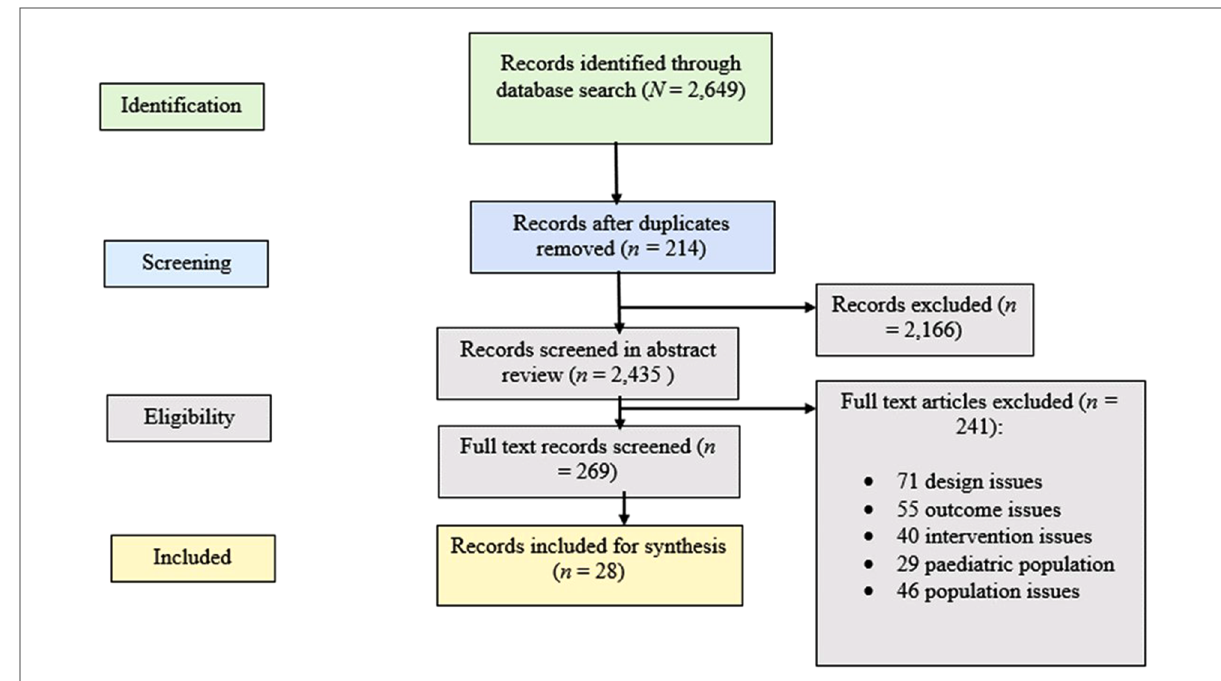
FIGURE 1 Details the number of records identi fi ed, included and excluded, and the reasons for